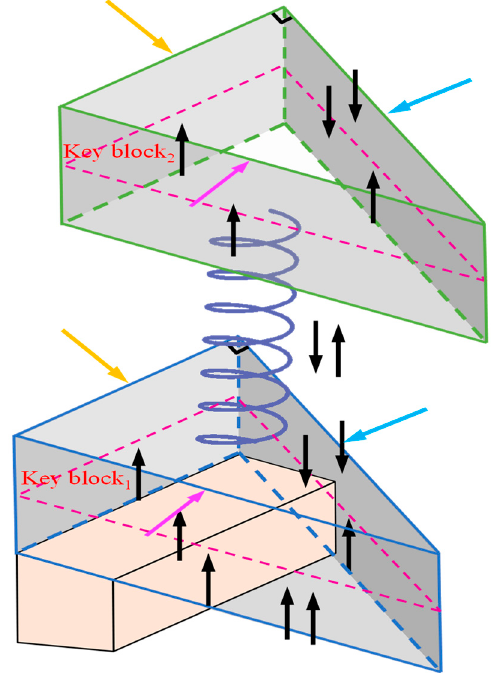
Figure 9. Mechanical analysis of high and low right angle key blocks [48].